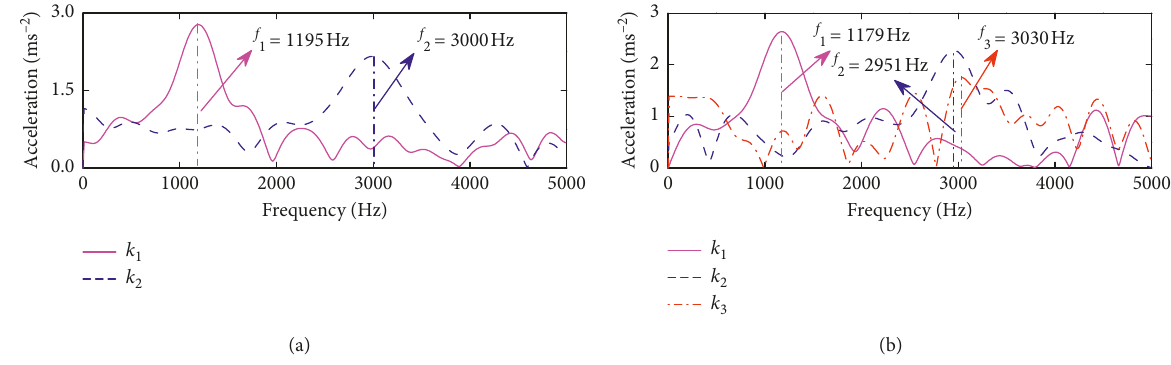
Figure 5: Amplitude-frequency spectra for estimating the types of impulse responses in Case 2.